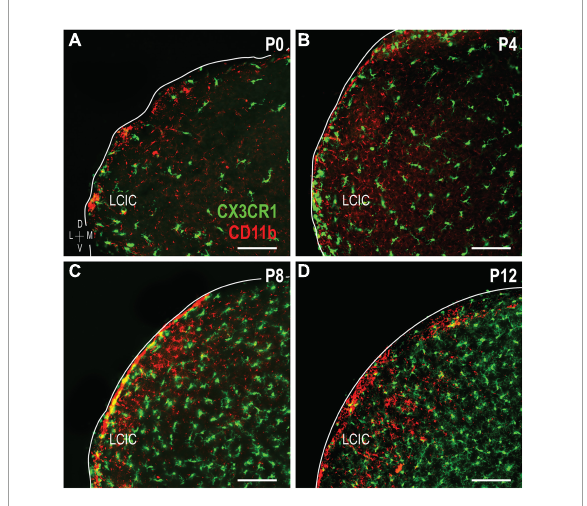
FIGURE6 Developmental progression of digital merges of integrin α M (CD11b) immunostaining in CX3CR1-GFP heterozygous mice (A–D) . Microglial cells (MGCs) expressing the fractalkine receptor (CX3CR1, green) appear to be distinct subpopulations from those expressing CD11b (red) in the lateral cortex of the inferior colliculus (LCIC) throughout its early critical period. CX3CR1 patterns shown here are in keeping with those recently reported Brett et al. (2022), namely with matrix dominated expression that rings modular domains at P4/P8, prior to entering modules at P12. This progression contrasts that for CD11b, which first shows preference for LCIC modules, prior to a later shift into surrounding matrix regions. Scale bars = 100 µ